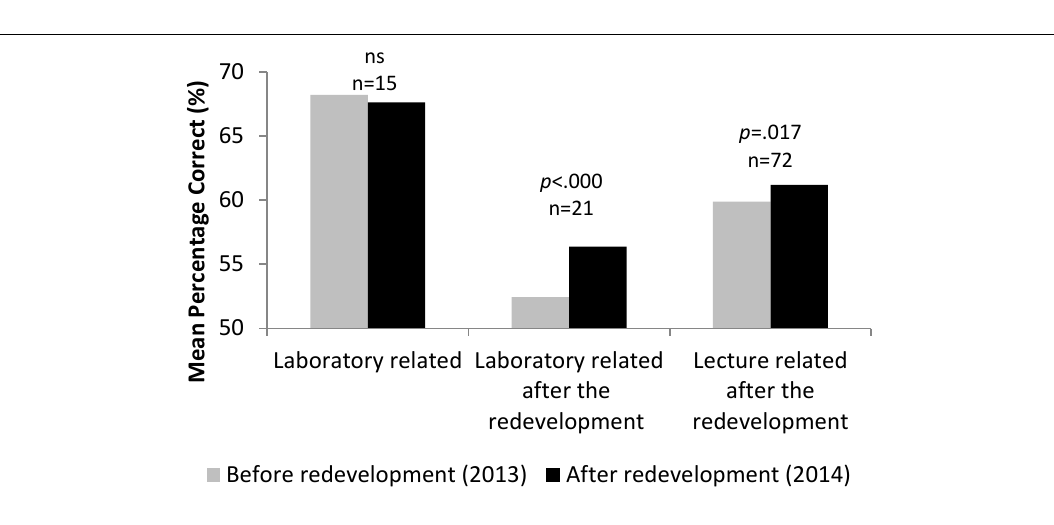
Figure 2: Categories of exam questions used in the analysis. The n value indicates number of questions in each category